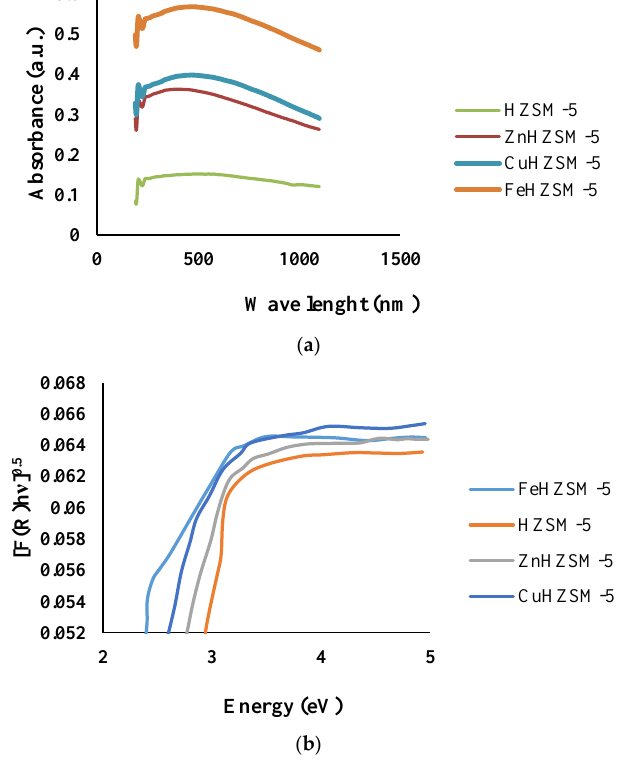
Figure 13. ( a ) Diffuse reflectance UV − visible absorption spectra for HZSM-5, 4 wt. % FeHZSM-5, 4 wt. % CuHZSM-5 and 4 wt. % ZnHZSM-5 catalysts; ( b ) Graphical of [ F ( R ∞ ) h ν ] 0.5 versus E for 4 wt. % FeHZSM-5, 4 wt. % CuHZSM-5 and 4 wt. % ZnHZSM-5 catalysts to determine the band